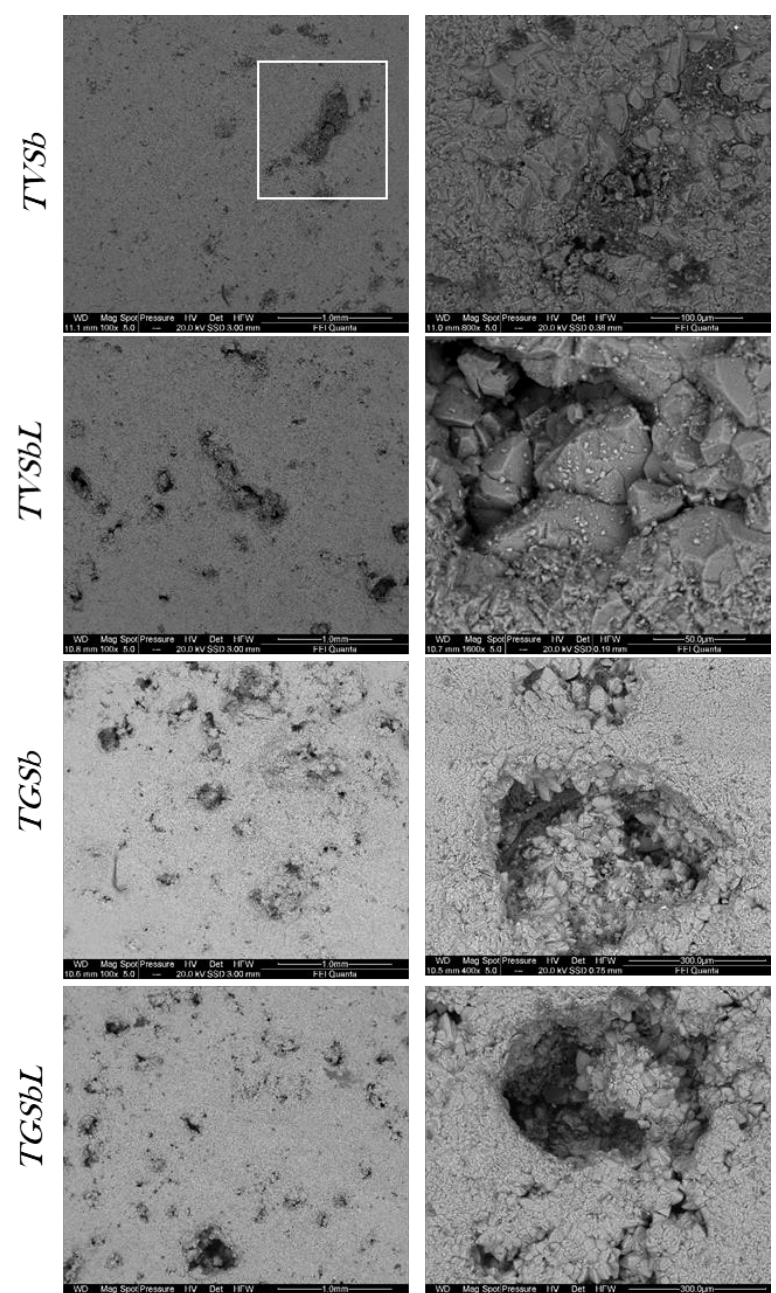
Figure 9. Scanning electron microscopy (SEM) micrographs of the travertine surfaces after the application of the cleaning methods tested. Check Table 3 for sample labels.